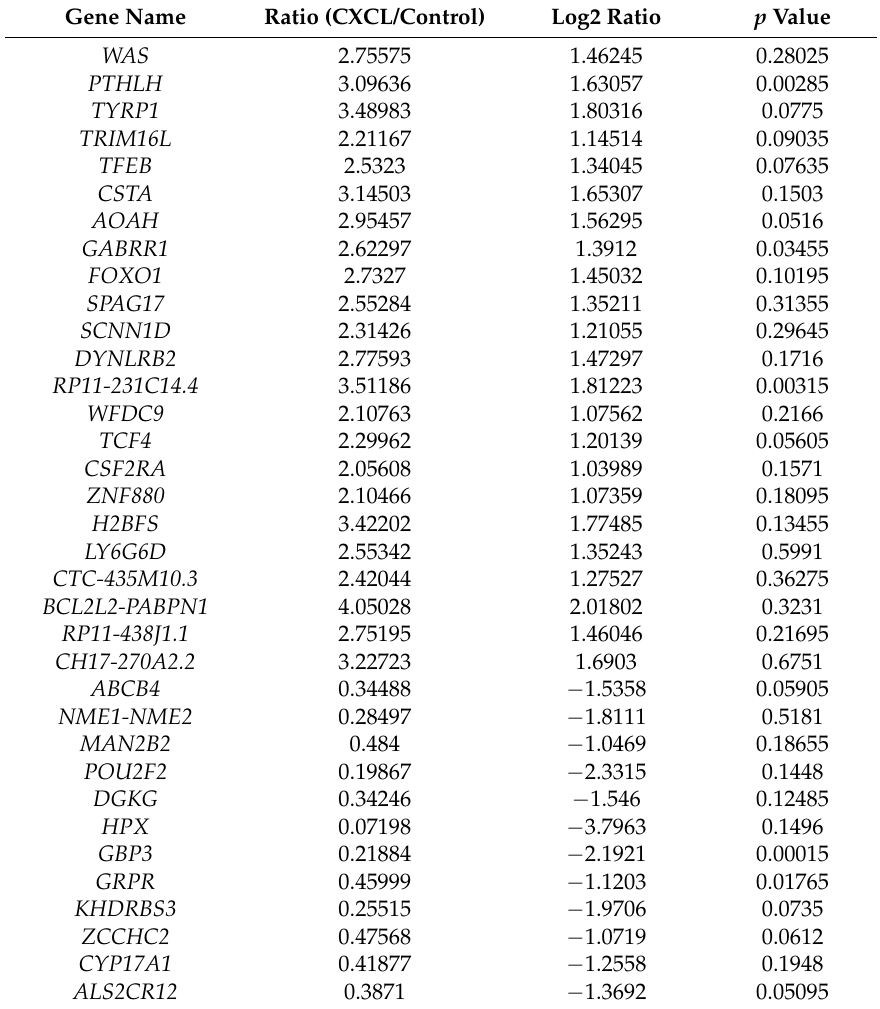
Table 1. Gene Profile of CXCL1-Treated SW620